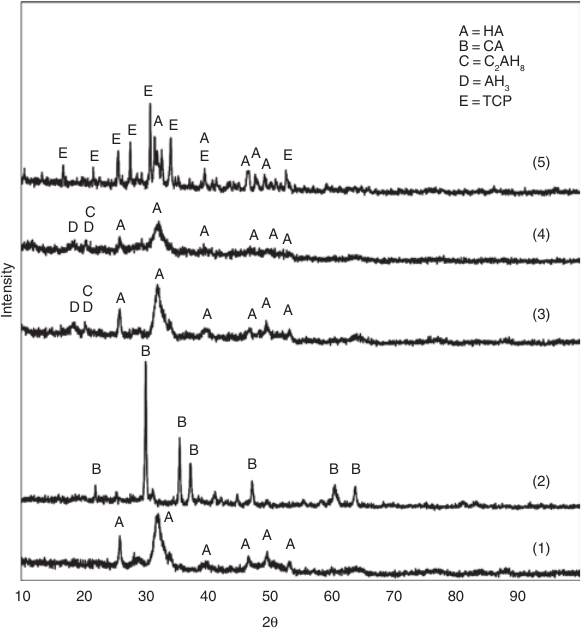
Figure 1: XRD patterns for HA (1), CA, (2) and nanocomposites syn- thesized by method 1 (3), method 2 (4), and method 3